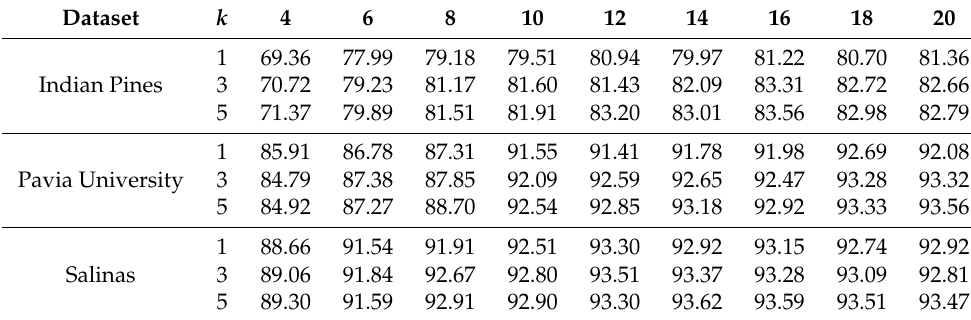
Table 2. Classification accuracies (%) of different parameter k on three datasets. Dataset